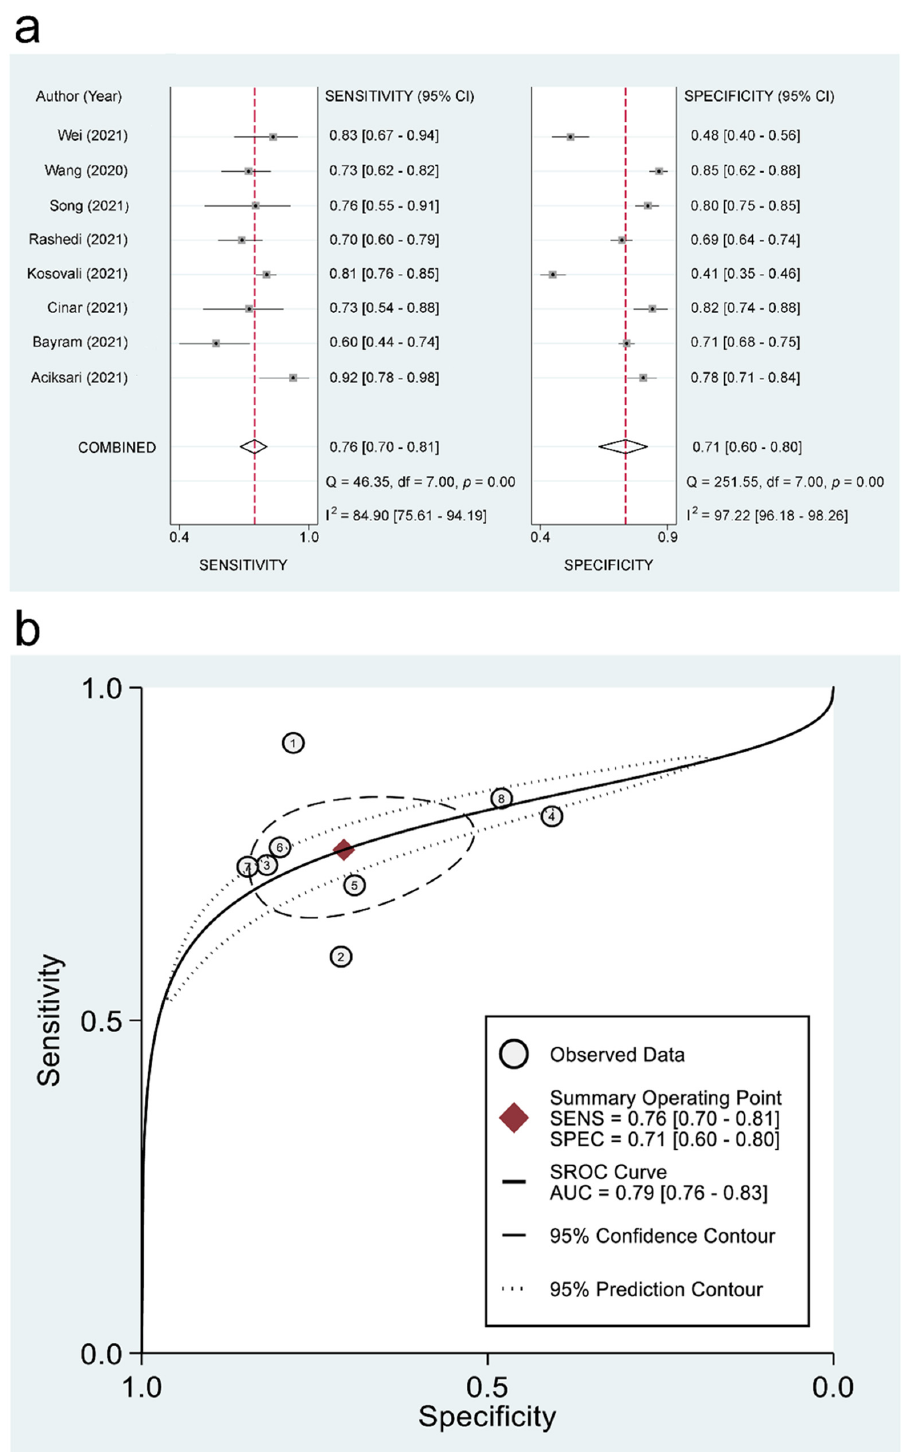
Figure 5. ( a ) Forest plots comparing the sensitivity and specificity of using prognostic nutritional index (PNI) for predicting in-hospital mortality in patients with COVID-19 among the included studies [11,19,20,21,28,32,34,36], and ( b ) hierarchical summary receiver operating characteristic (hsROC) curves of using PNI for the prediction of in-hospital mortality in patients with COVID-19. SENS: Sensitivity, SPEC: Specificity, SROC: Summary receiver operating characteristic, and AUC: Area under the curve.